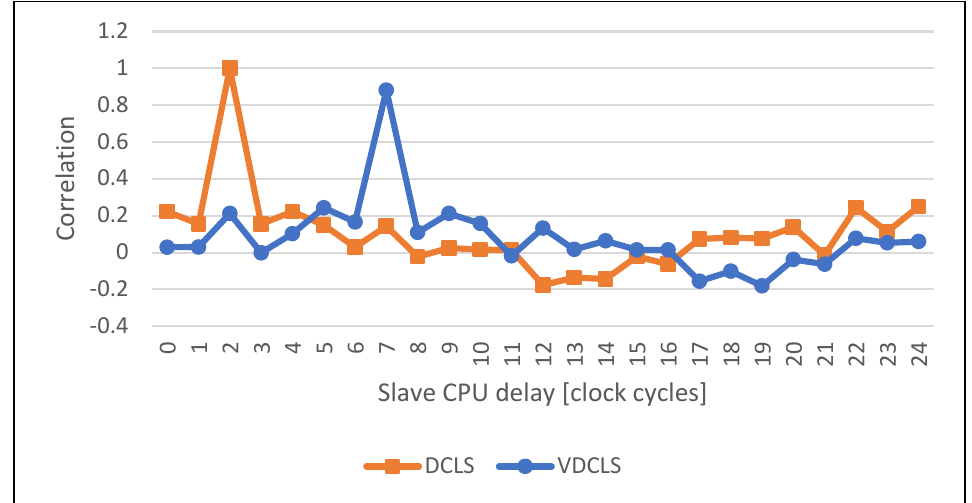
Figure 15. Comparison of the execution correlation between master and slave CPUs using VDCLS and legacy DCLS technique while executing the Galois field GF (2 8 ) functions.